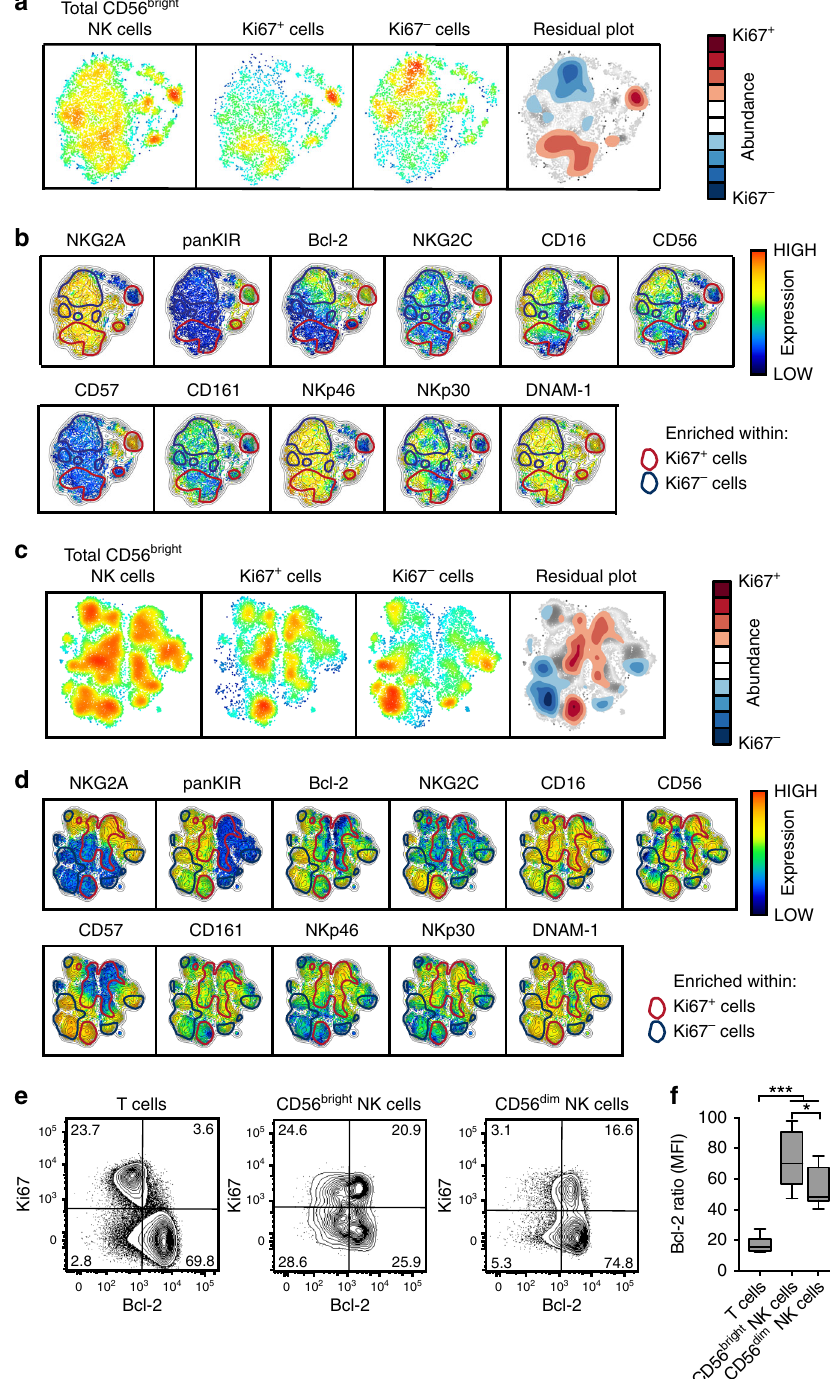
Fig. 2 High-dimensional analysis of natural killer (NK) cells responding (Ki67 + and Ki67 − ) during acute dengue virus (DENV) infection. a Barnes – Hut stochastic neighbor embedding (Bh-SNE) maps on total CD56 bright NK cells and separated for responding (Ki67 + ) and non-responding (Ki67 − ) cells. Residual plot showing the difference between responding and non-responding maps. Analysis is based on data from three representative patients at the acute phase of infection with 5000 events per subset and patient. b Relative expression intensities of the 11 indicated parameters that were used in the SNE analysis. Phenotypes within red circles are more common in responding NK cells and vice versa for blue circles in non-responding NK cells. c , d Similar analysis as in a , b but for CD56 dim NK cells. e Representative fl ow cytometry staining for Bcl-2 and Ki67 expression of T cells, CD56 bright NK cells, and CD56 dim NK cells from one representative patient at the acute phase of infection. f Comparison of Bcl-2 expression using the median fl uorescence intensity ratio (MFI, ratio of Ki67 + normalized to Ki67 − ) within T cells, CD56 bright NK cells, and CD56 dim NK cells ( n = 9). Lowest and highest observations are displayed with the median indicated as center line. Statistical differences in f were tested using one-way analysis of variance (ANOVA) followed by Holm – Sidak ’ s multiple comparison test. * P < 0.05 and *** p < 0.001. Source data are provided as a Source Data fi